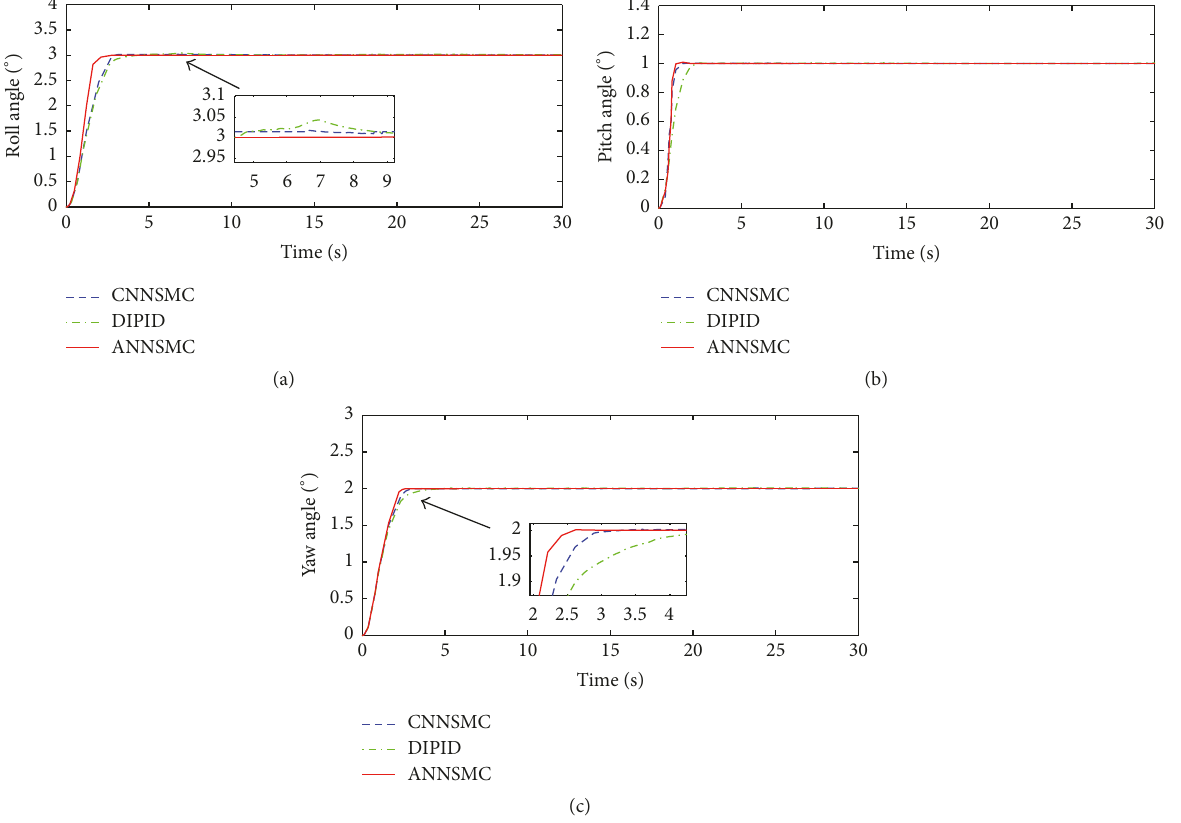
Figure 7: Helicopter attitude behavior response to the step